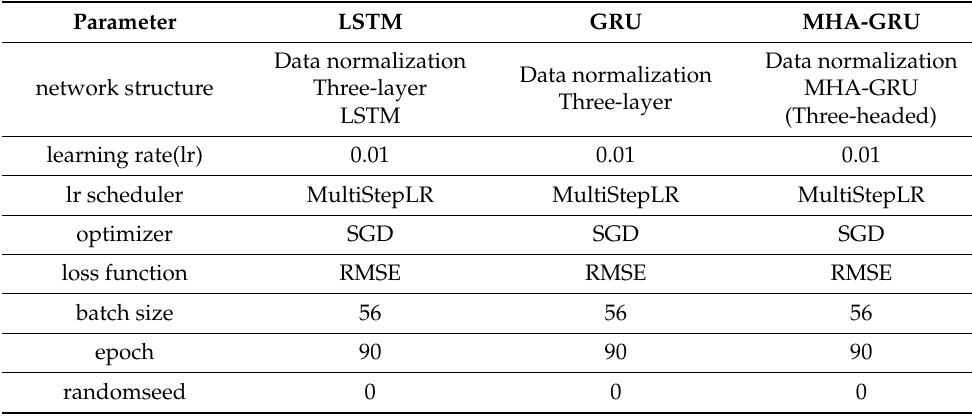
Table 1. Parameter setup for different machine learning methods.